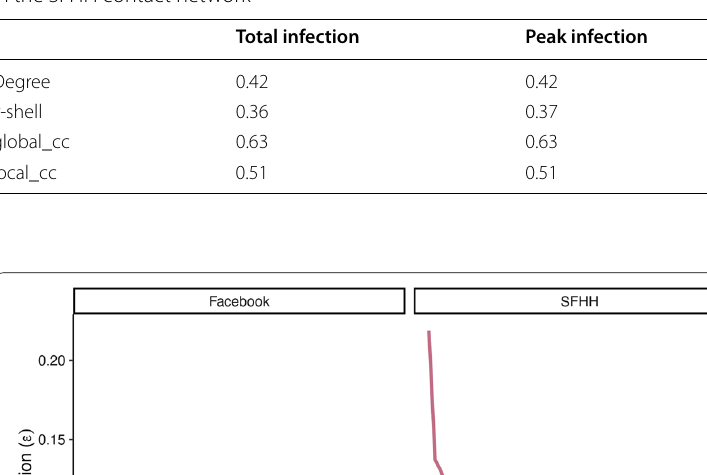
Table 3 Pearson correlations of the true spreading capability of nodes with the different measures in the SFHH contact network